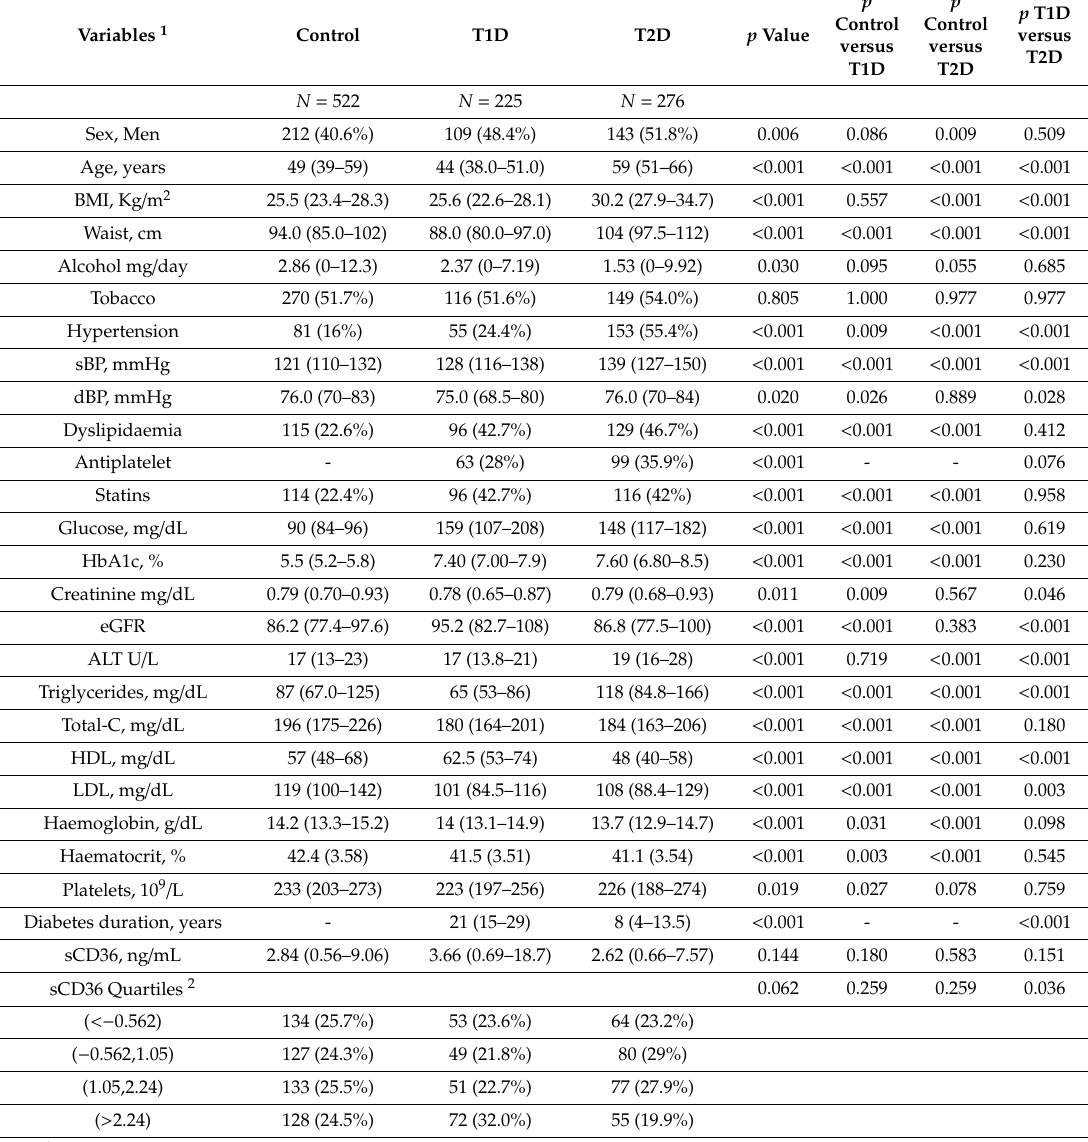
Table 1. Clinical and anthropometrical characteristics of the study